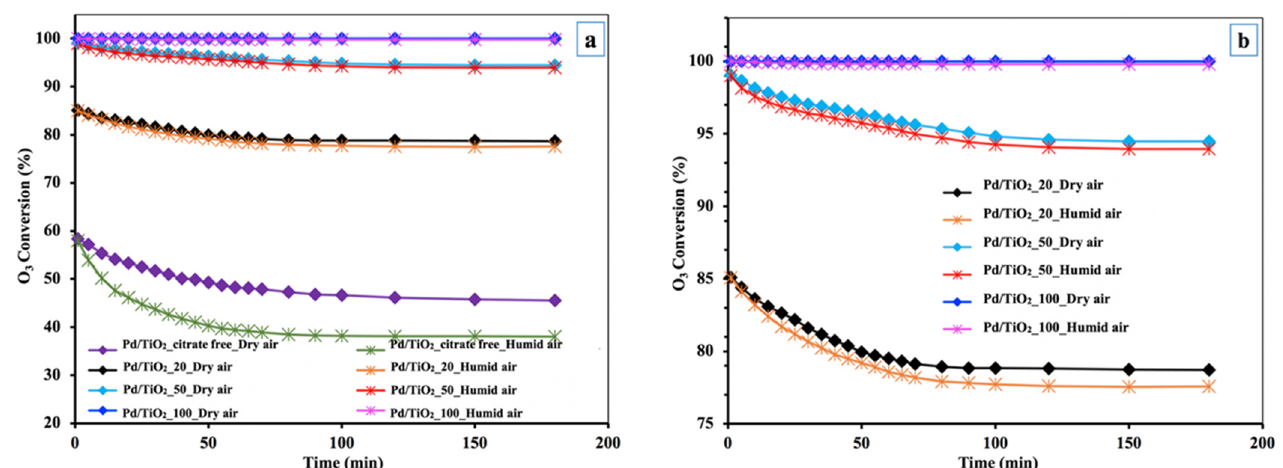
Figure 7. ( a ) Ozone conversion as a function of time on stream in dry and humid condi- tions for the Pd/TiO 2 _x (x = 20, 50, 100) and Pd/TiO 2 _citrate free catalysts. (Experimental conditions: catalyst = 10 mg, O 3 = 15 ppm, H 2 O = 3130 ppm (corresponding to RH = 10%), flow rate = 1000 mL min − 1 , T = 25 ◦ C). ( b ) Enlargement of ( a ) in the 75–100% conversion range.